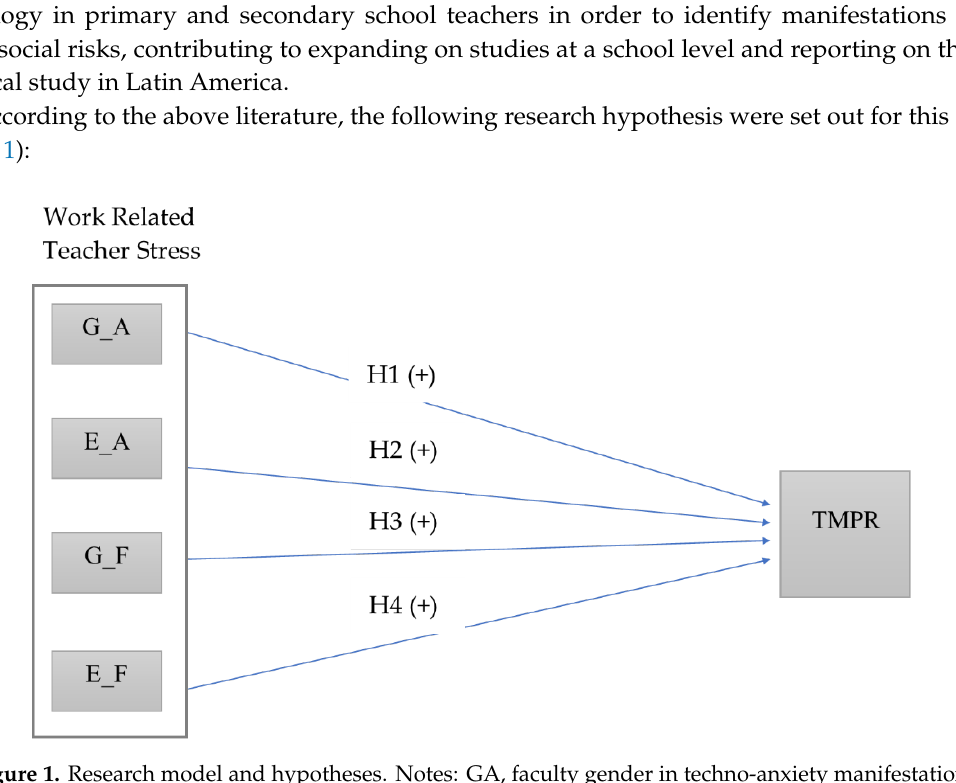
Figure 1. Research model and hypotheses. Notes: GA, faculty gender in techno-anxiety manifestation; EA, faculty age section in techno-anxiety manifestation; GF, faculty gender in techno-fatigue manifestation; EF, faculty age section of teachers in techno-anxiety manifestation; TMPR, technostress manifestations in psychosocial risk. Source: own